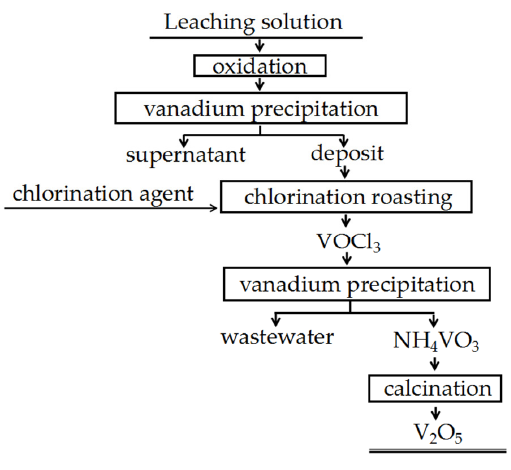
Figure 1. Flow chart of short-process preparation of V 2 O 5